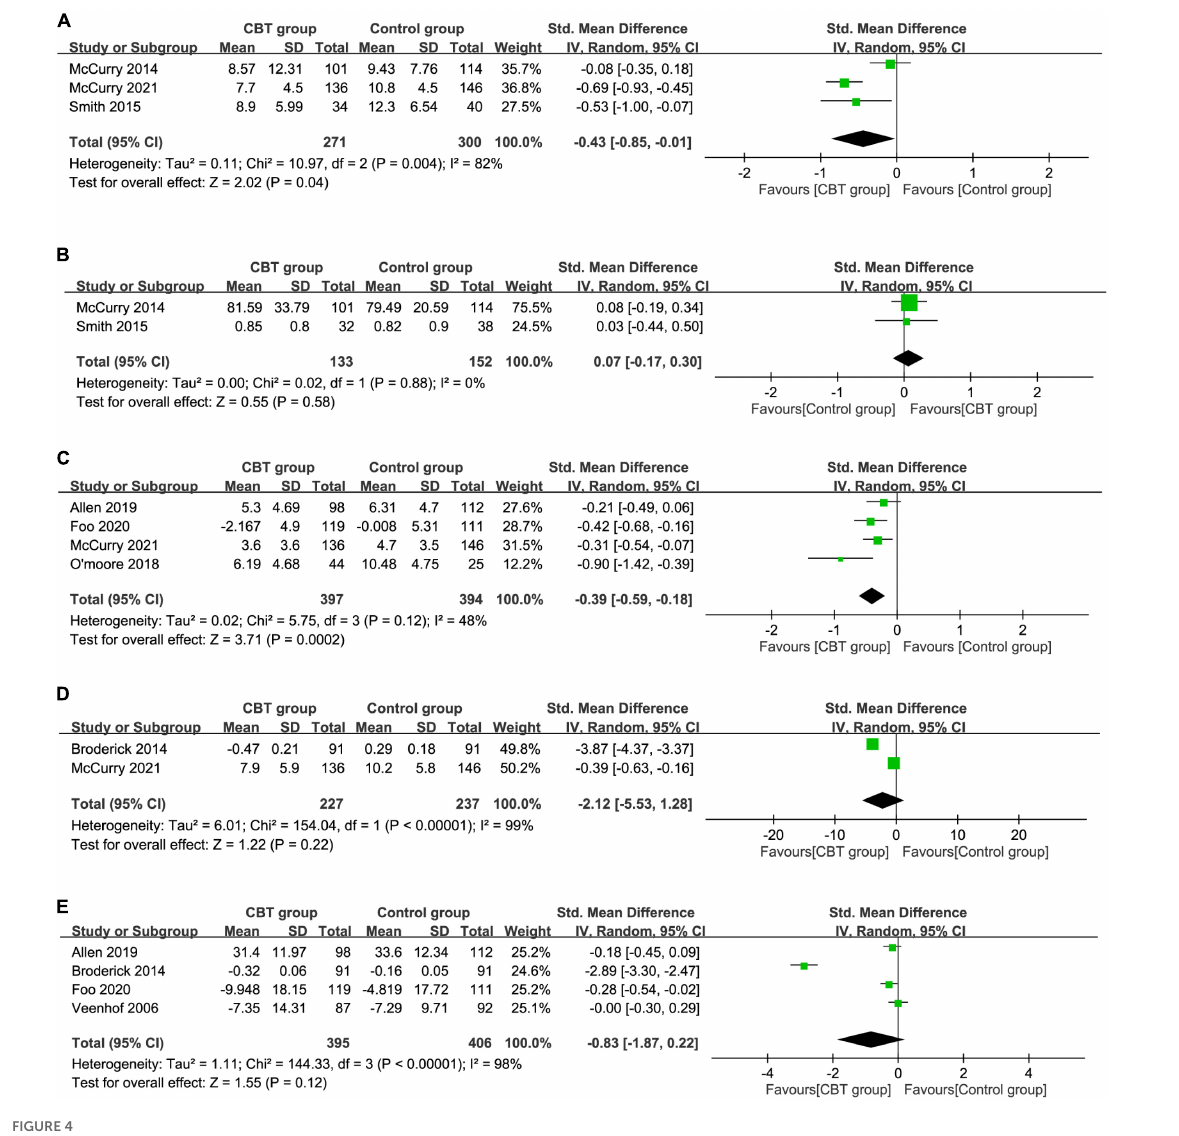
FIGURE4 Forest plot comparing (A) insomnia severity, (B) sleep efficiency, (C) depression severity, (D) fatigue severity, and (E) physical function during the follow-up period between the cognitive behavior therapy (CBT) and control groups. Std, standardized; iv, inverse variance; CI, confidence